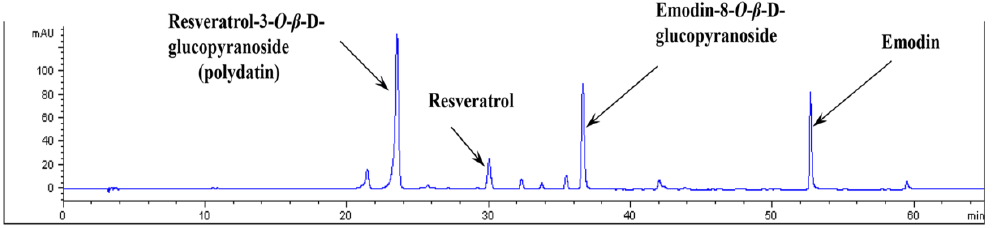
Figure 1. High performance liquid chromatography analysis. A qualitative analysis was performed to detect the fingerprint of PCE using high ‐ performance liquid chromatography (HPLC). The compounds were identified by their peak retention times relative to reference substances.